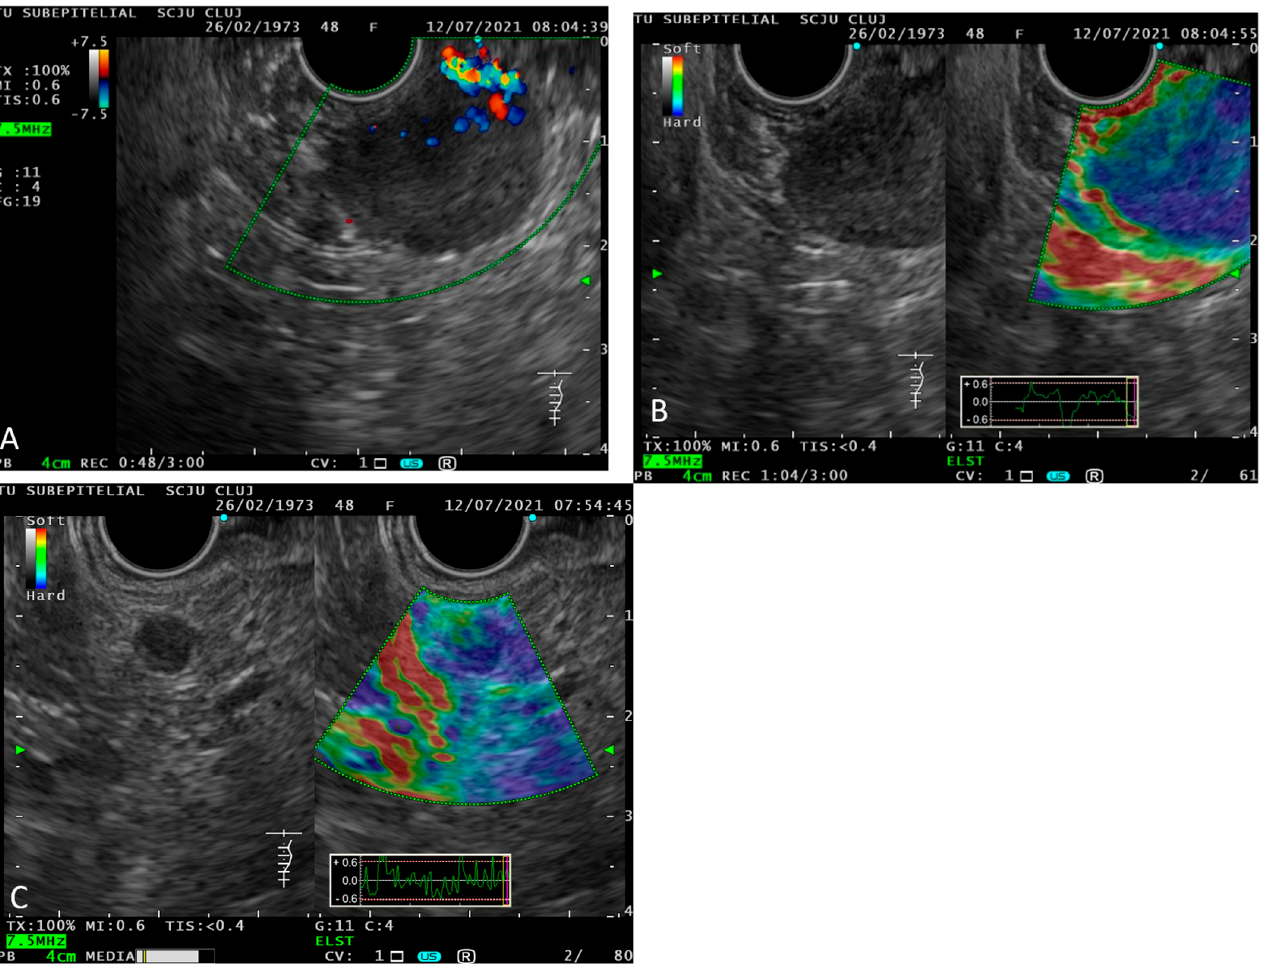
Figure 4. EUS periampular tumor in US, Doppler-US and elastography showing the vascular pedicle and increased rigidity of the tumoral mass ( A , B ); EUS periduodenal lymph node: image in ( B ) mode and elastography showing increased nodule rigidity ( C ).